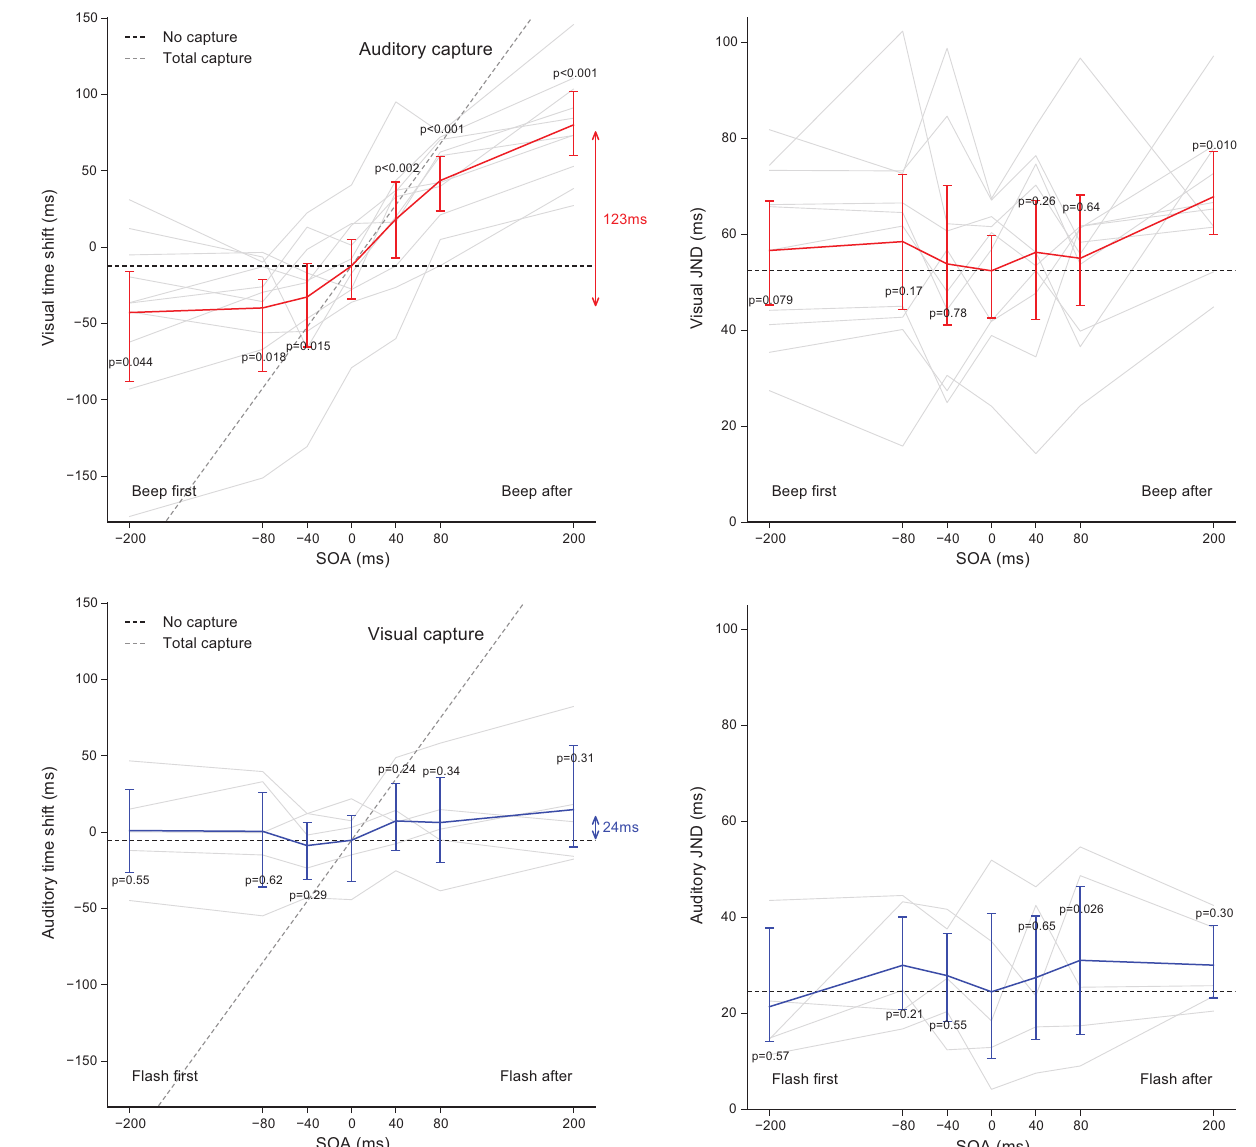
Fig 3. Results of Experiment 1 and 2. Visual time shift producedby auditory capture (in red, Experiment 1) and auditorytime shift producedby visual capture (in blue, Experiment2) accordingto the SOA (left plots) , and the corresponding visual and auditory JNDs (right plots) . The red and blue solid lines show the averages across participants (gray lines: individualresults, error bars: 95% confidence intervals). Black and gray dashedlines show the predictionsfor absenceof capture (SOA = 0ms baseline)and total capture. For each condition, p-values indicatehow significantis the difference with the SOA = 0ms condition(pairedStudent’s t-tests with α set at 0.00833 using Bonferroni correction for multiple